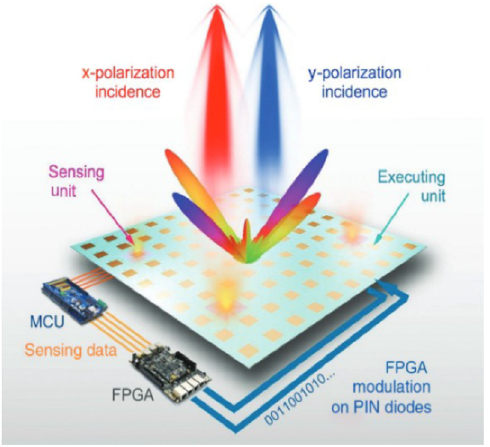
Figure 25: The dynamic holographic metasurface [117]. Reprinted from [117], with the permission of Nature